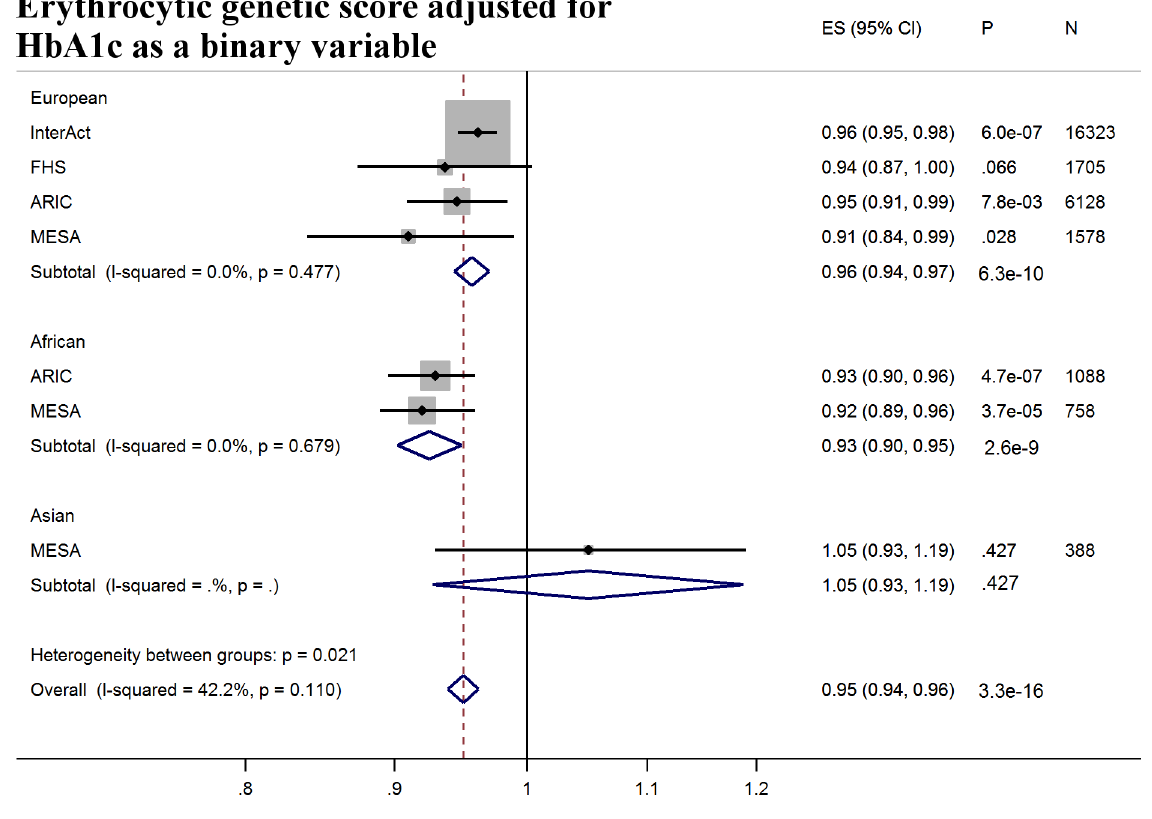
Fig 4. T2D prediction, erythrocytic genetic score adjusted for HbA1c as a binary variable. Forest plot of associationbetween erythrocytic geneticscore with incidentT2D over a decade-longfollow-upperiodadjusted for HbA1c as a binary variable( (cid:21) 5.7% versus < 5.7%), by ancestry. HbA1c at baselinewas not availablein SCHS and was excludedfrom the meta-analysis. MESA (European and Asian ancestry) and the G6PD variant (rs1050828)in ARIC (European and African American) were not includedin the